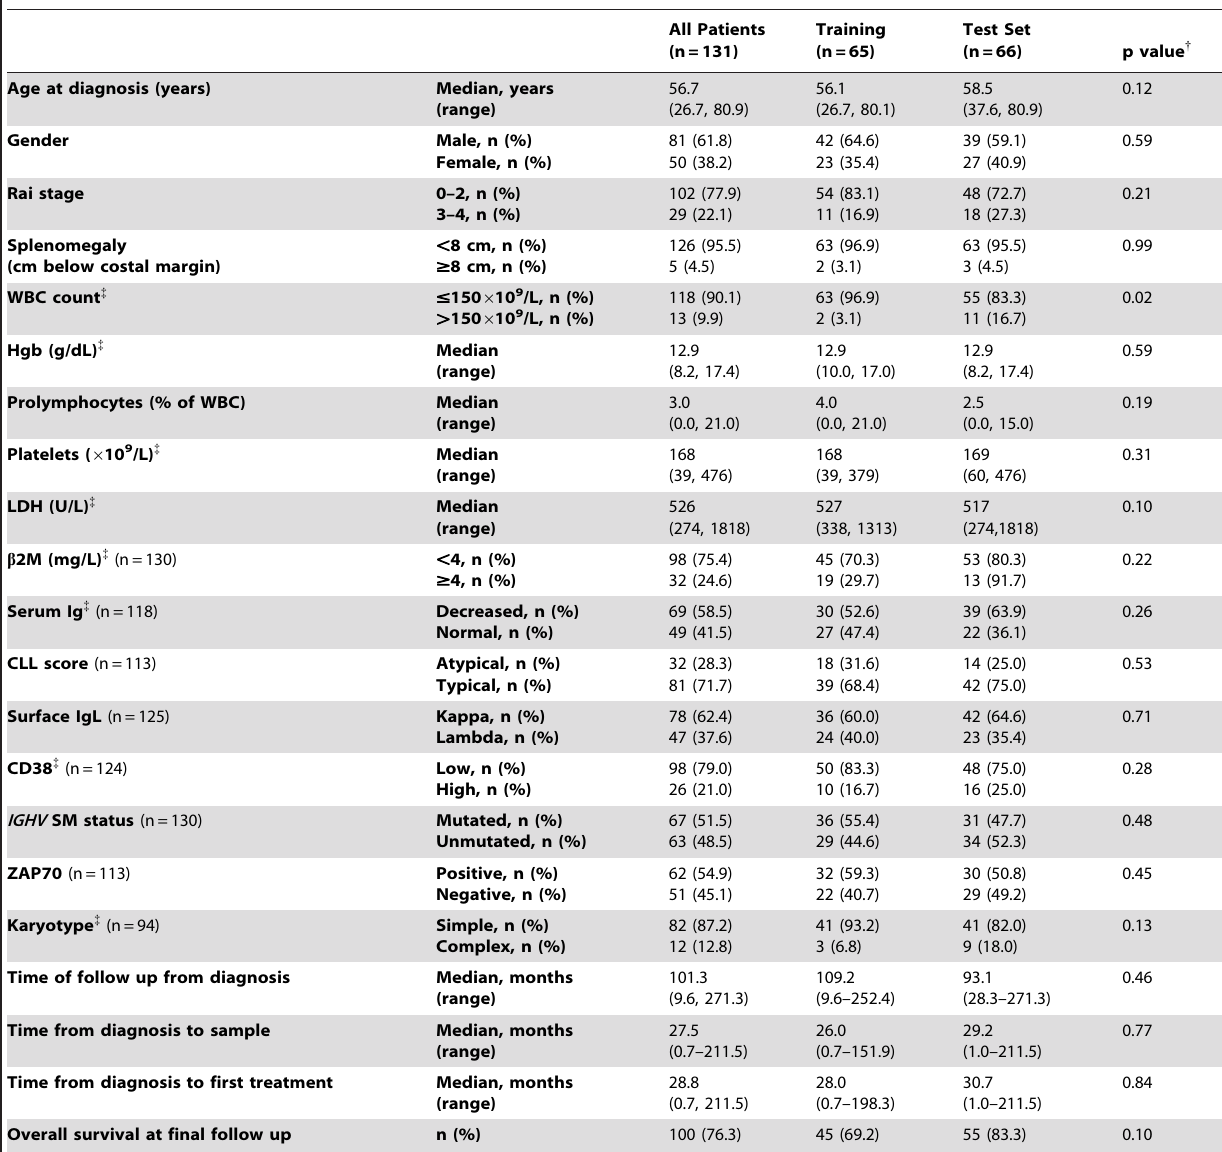
Table 1. Clinical and Laboratory